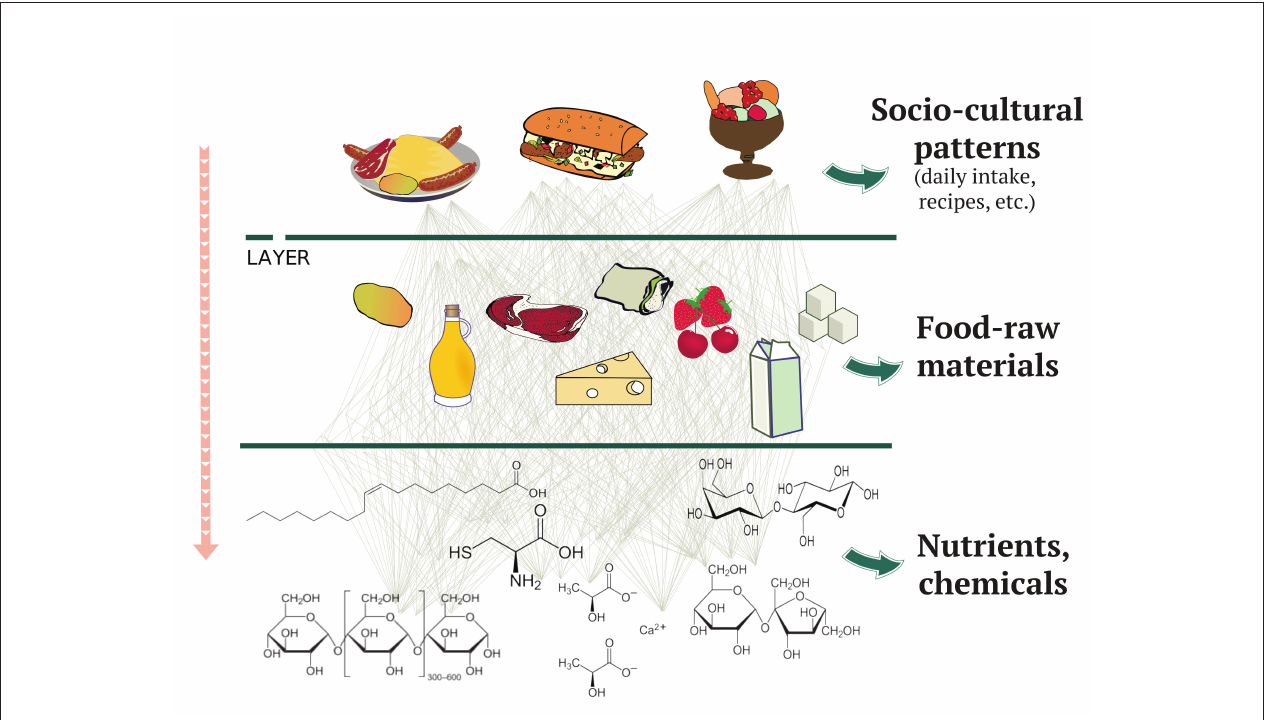
FIGURE 1 | Multilayer schematic representation of the interactions that are involved at three different complexity levels. These interactions link together food composition and socio-cultural covariates. Each layer is represented as a network of interactions among the components at that scale.